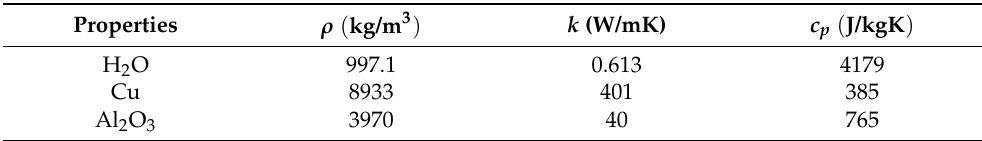
Table 1. Properties of H 2 O and nanoparticles